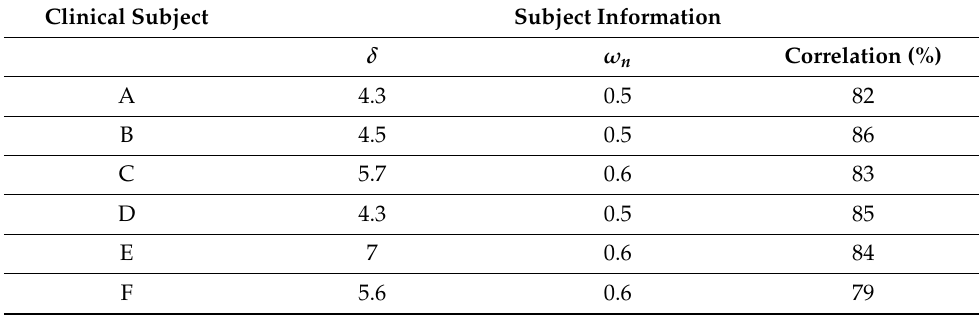
Table 2. Estimated heart rate model parameter using